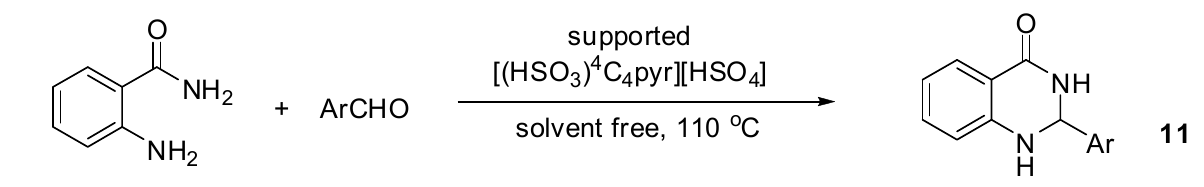
Scheme 28. Synthesis of 2,3-dihydroquinazolin-4(1H)-ones ( 11 ) by a cyclocondensation